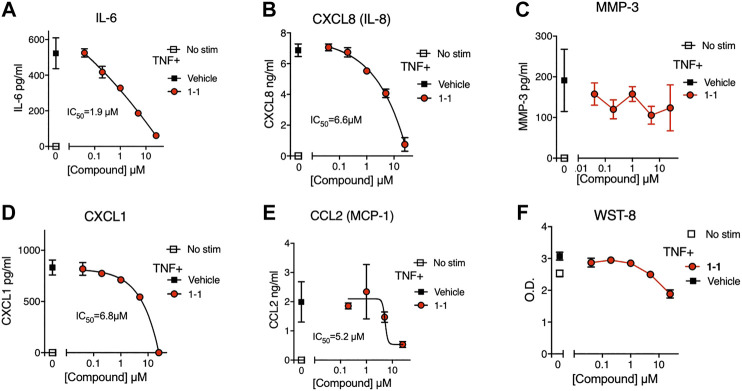
Compound 1-1 suppresses chemokine and cytokine release by TNF stimulated RA FLS; (A–E) Chemokine and cytokine production by RA FLS stimulated with 1 ng/ml of TNF for overnight with graded dilutions of compound 1–1. The supernatants were assayed for IL-6; (A), CXCL8; (B), MMP-3; (C), CXCL1; (D) and CCL2; (E). (F) Cell viability was assessed by WST-8 assay. DMSO was 0.1% of the final concentration as vehicle. Data are represented as mean ± SD. The IC50 values are shown. Data are representative of two independent experiments showing similar results.